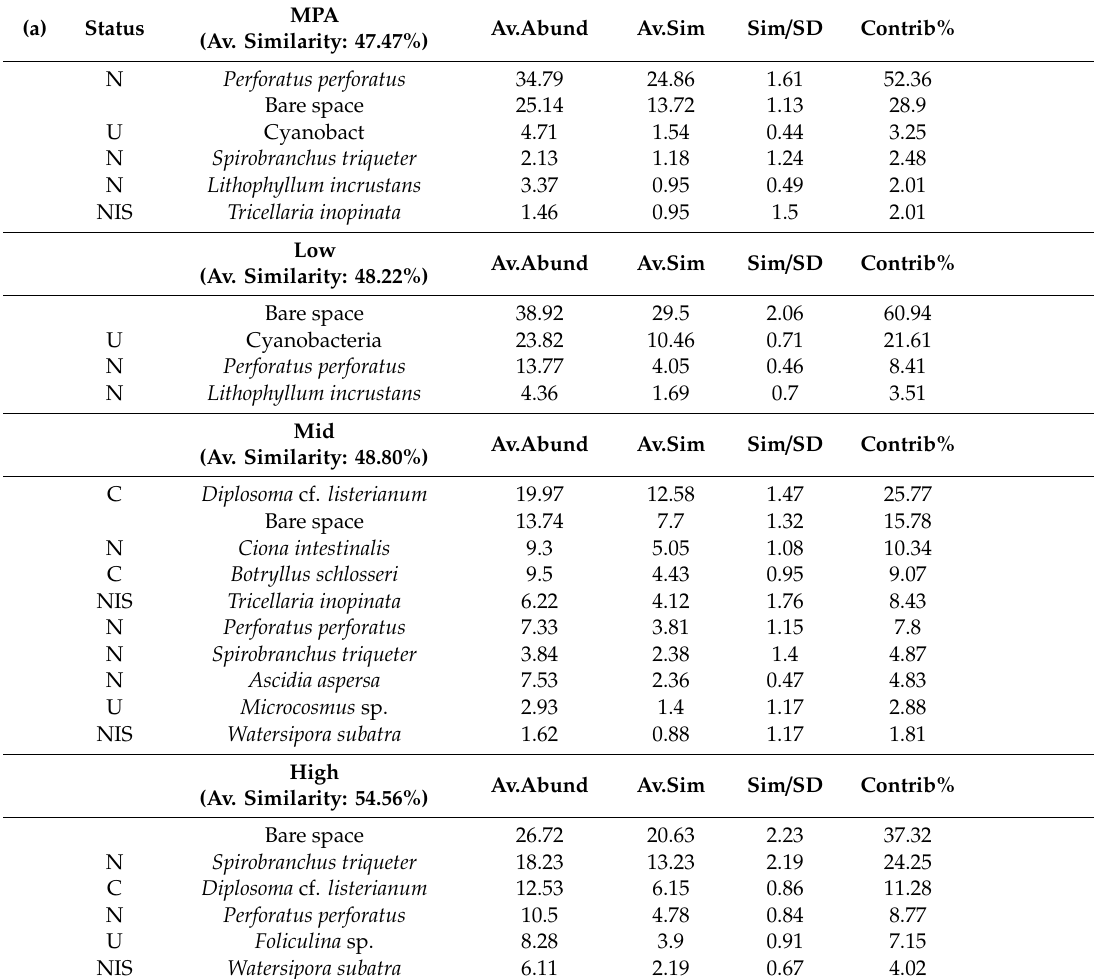
Table 7. SIMPER analysis on macrofouling untransformed data showing the contribution of taxa to the average Bray–Curtis (a) similarity within “Pressure” groups and (b) dissimilarity between “Origin of biofilm” across “Pressure” levels. Average (dis)similarities are indicated in